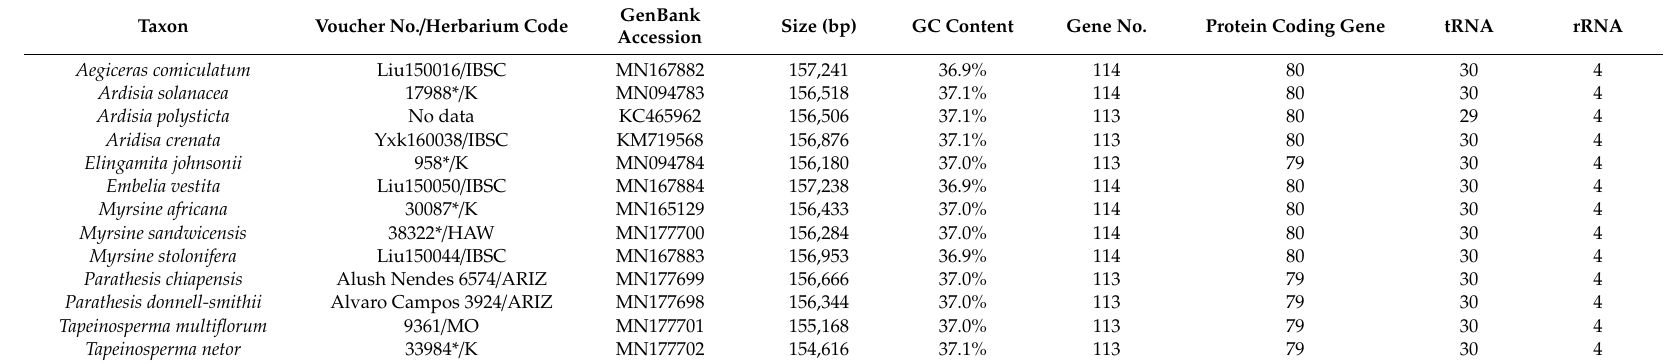
Table 1. Details on samples, vouchers, GenBank accessions, and features of the chloroplast genomes within the Myrsinaceae s.str.